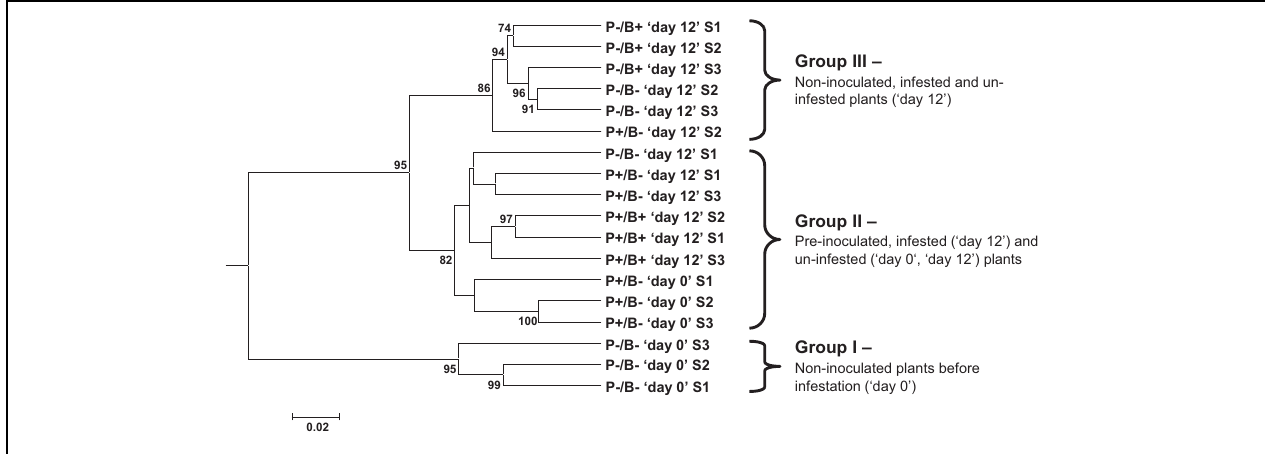
FIGURE 2 | Cluster analysis of tomato rhizosphere bacterial community patterns. DGGE patterns were aligned using Fingerprinting® II software and the samples’ densitometric curves were extracted. Unweighted pair-group method with arithmetic mean (UPGMA) algorithm was applied to a Bray-Curtis distance matrix calculated between the samples densitometric